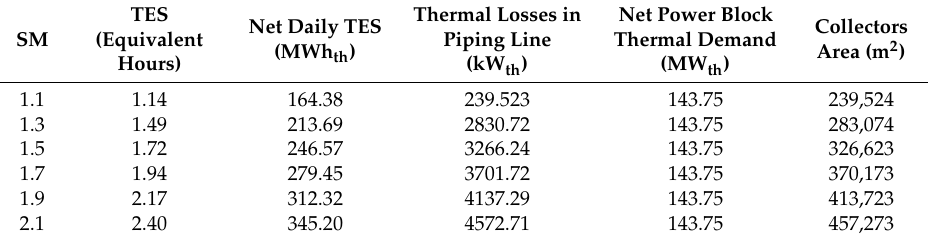
Table 4. Thermal energy storage and collector area oversize as a function of solar